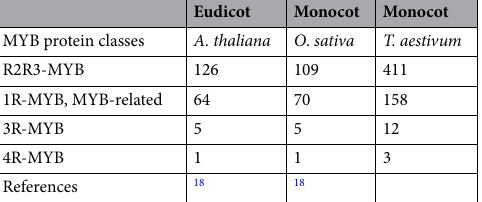
Eudicot Monocot